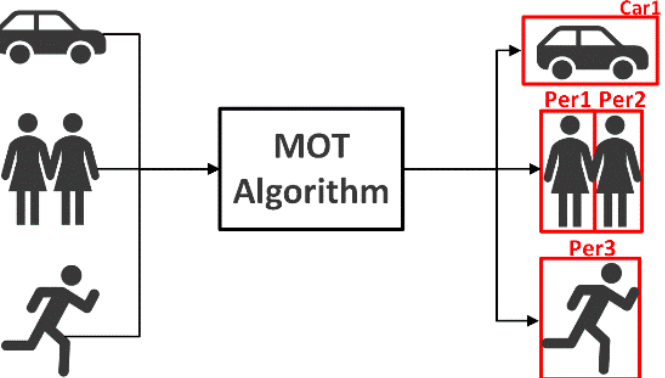
Figure 1. An illustration of the output of an MOT algorithm. Each output bounding box has a number that identifies a specific object in the video.